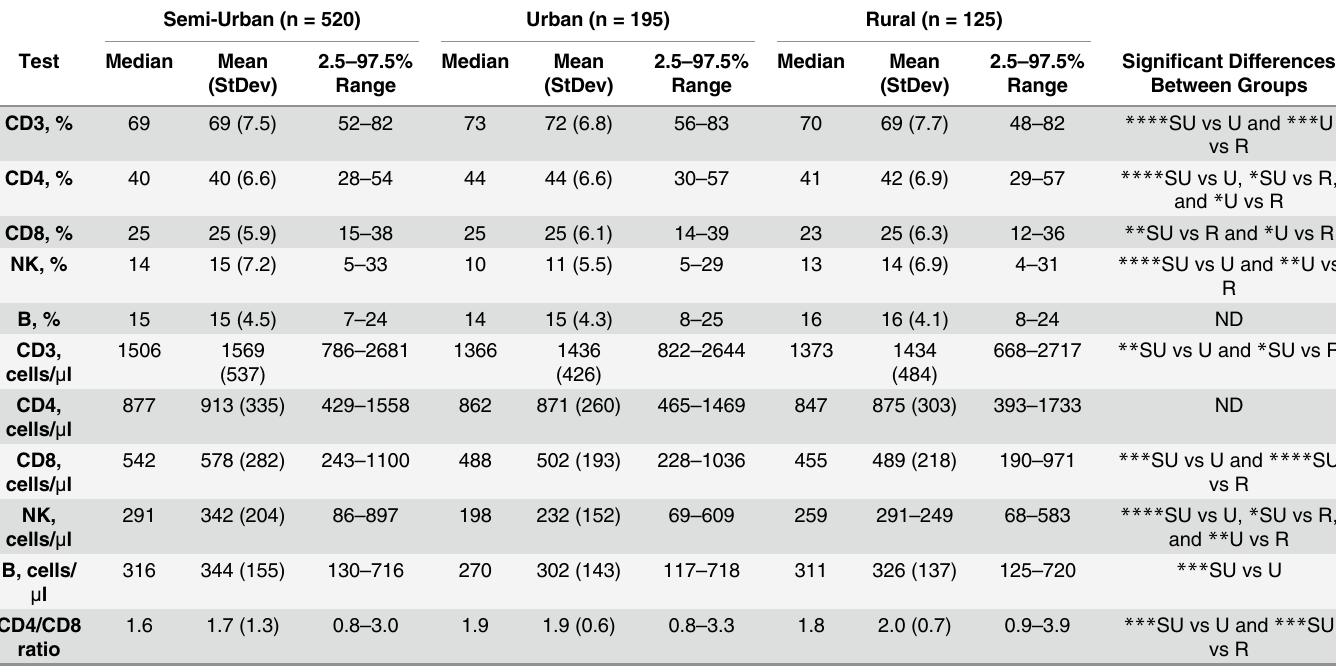
Table 3. Comparison of lymphocyte subset frequency and absolute counts in males. Semi-Urban (n =